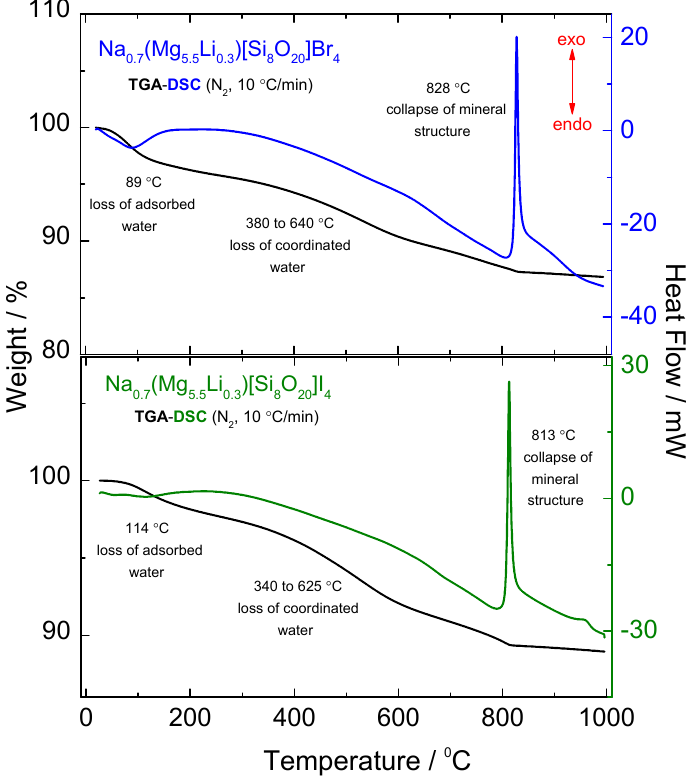
Figure 6. The heating TGA-DSC curves of the bromohectorite ( top ) and iodohectorite ( bottom ).